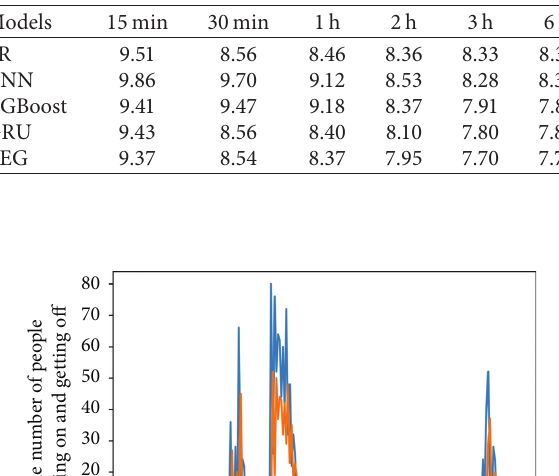
Table 6: Multimodel RMSE comparison table for different step sizes.